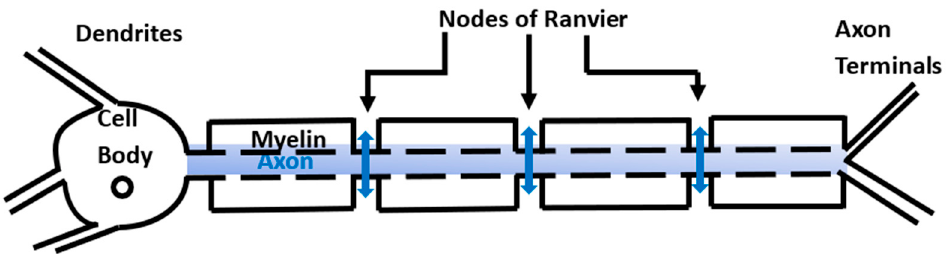
Figure 1. In a myelinated neuron, action potentials (blue vertical double arrows) happen only at the nodes of Ranvier and propagate between the cell body and the axon terminals (bidirectional propagation).